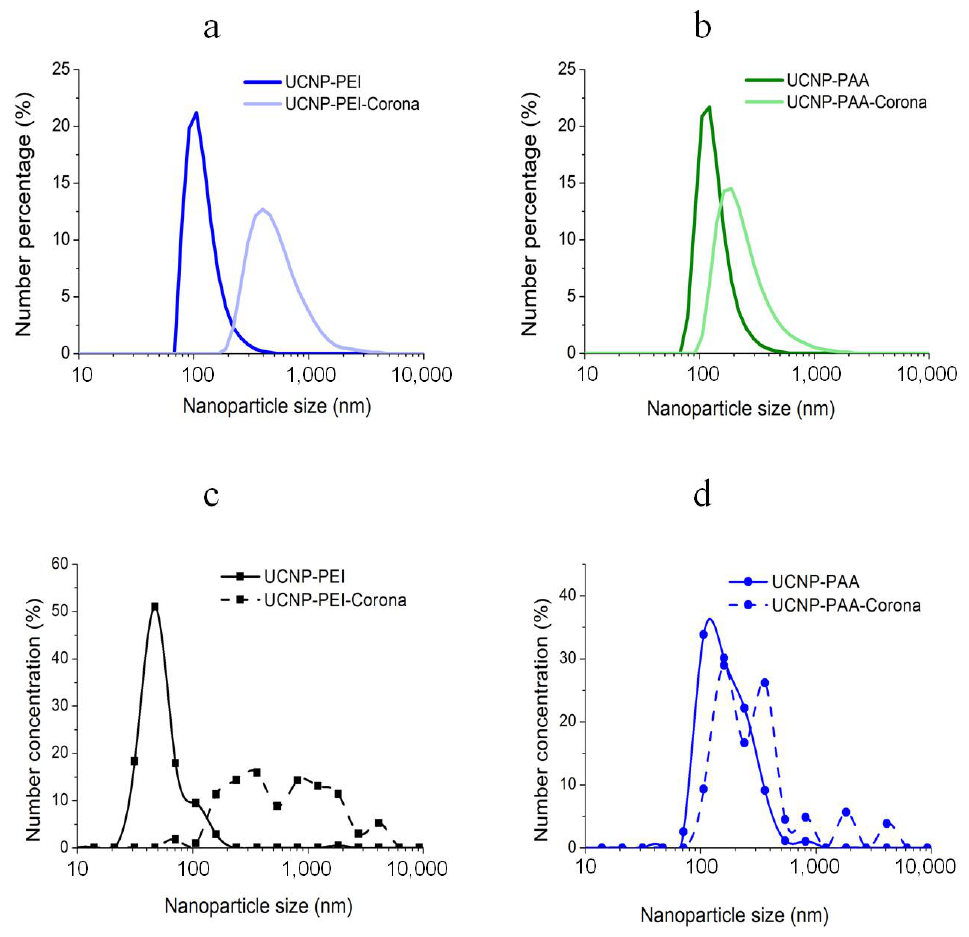
Figure 10. Hydrodynamic particle size distributions of aqueous dispersions of UCNPs (NaYF 4 : 20% Yb, 8% Tm) with PEI and PAA surface modifications and their hard PC-coated samples obtained by DLS ( a , b ) and FCS ( c , d ). Data for intact UCNPs are represented in a solid line, data for UCNPs modified with PC are